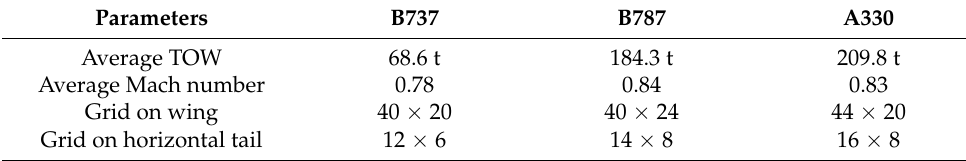
Table 3. Related parameters of three aircraft